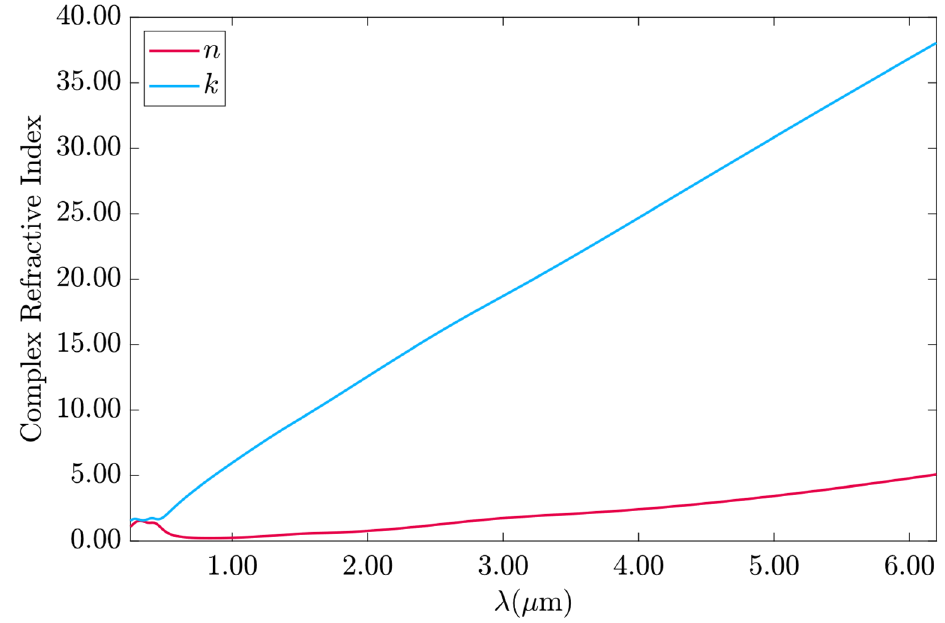
Figure 4. The complex refractive index of gold from the Drude–Lorentz model.